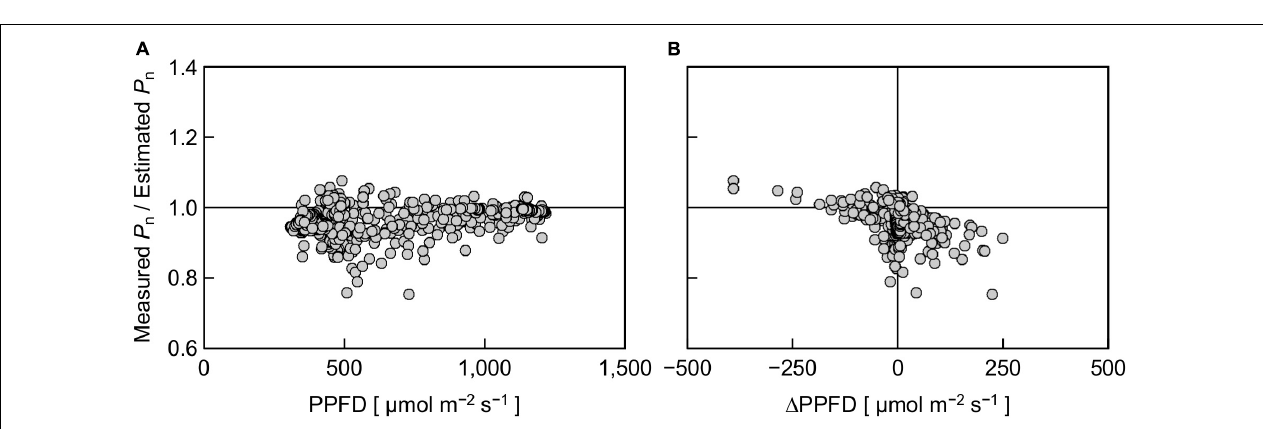
FIGURE 7 | The ratio of measured P n to estimated P n in response to PPFD at a given moment (A) and the ratio in response to a change in PPFD for 15 s ( (cid:49) PPFD) (B) . Positive and negative (cid:49) PPFD values represent increases and decreases in PPFD, respectively.